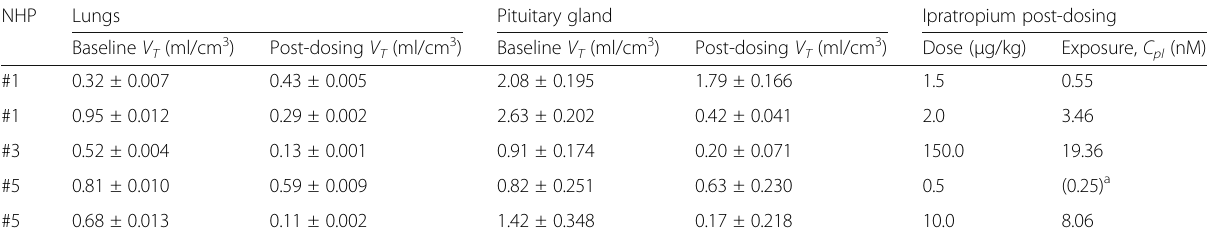
Table 4 Total radioligand binding ( V T ± standard error) in lungs and pituitary gland; ipratropium inhalation dose and average plasma